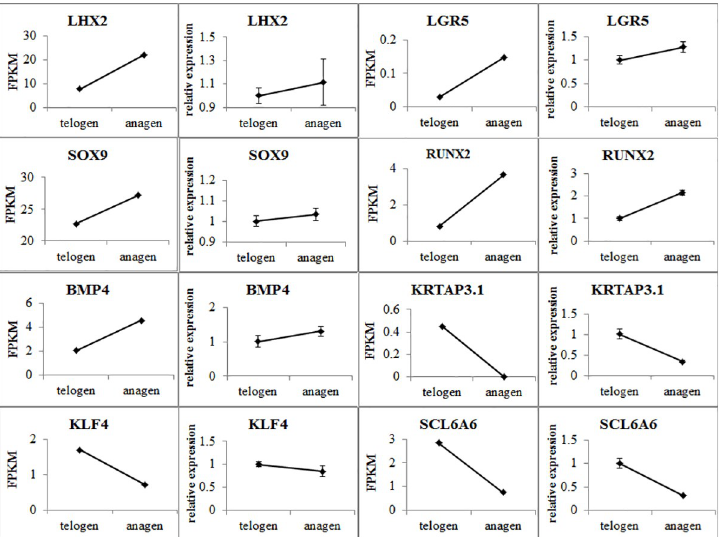
Fig 5. qRT-PCR validation of the RNA-Seq data. The qRT-PCR data are shown as the means ± standard error (SE) of three replicates. FPKM values from the RNA-Seq analysis are shown as the means and SE of three replicates. The left side shows the qRT-PCR data, while the right side shows the FPKM values from the RNA-Seq results.